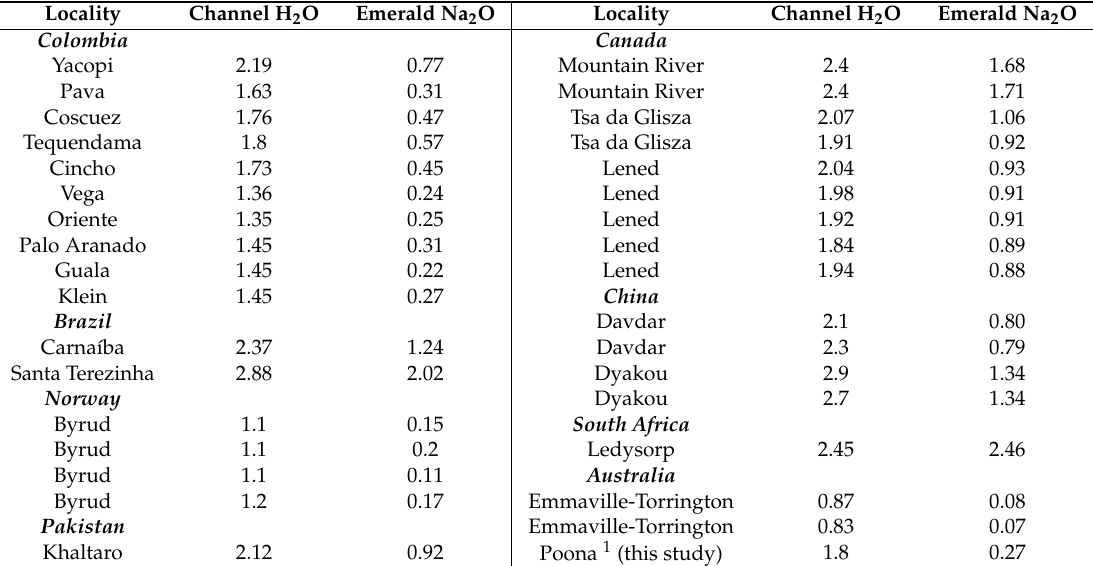
Table 2. Channel H 2 O and Na 2 O contents (weight %) of various emerald deposits worldwide. Locality